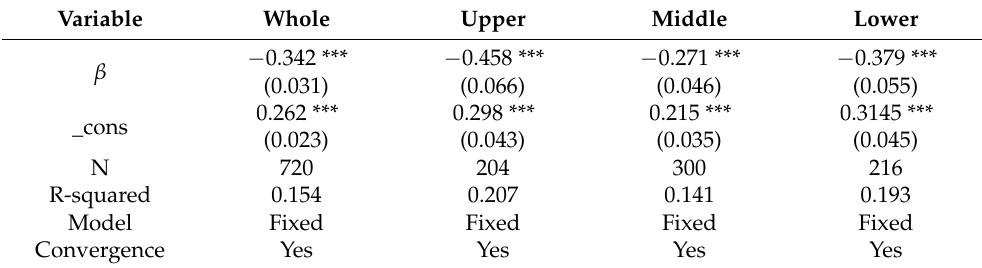
Table 7. Absolute β -convergence test results for the YRB during the period from 2006 to 2018. Variable